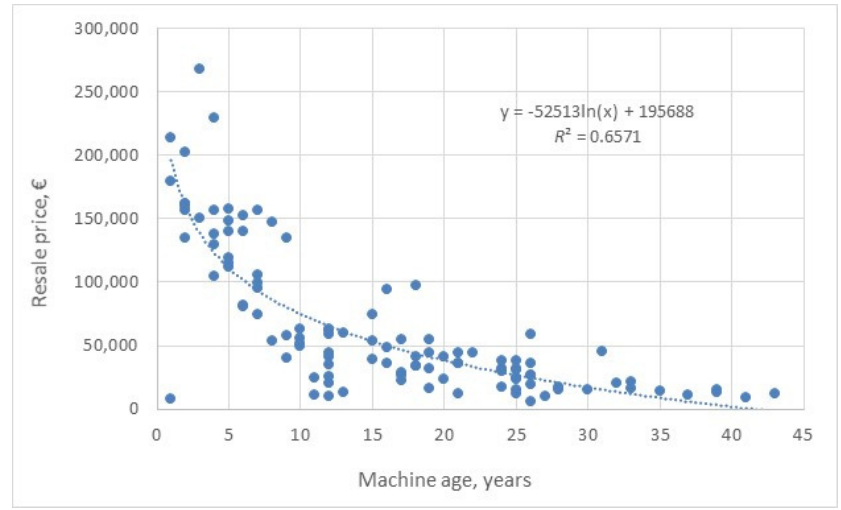
Figure 3. Relationship between skidder resale price and machine age.